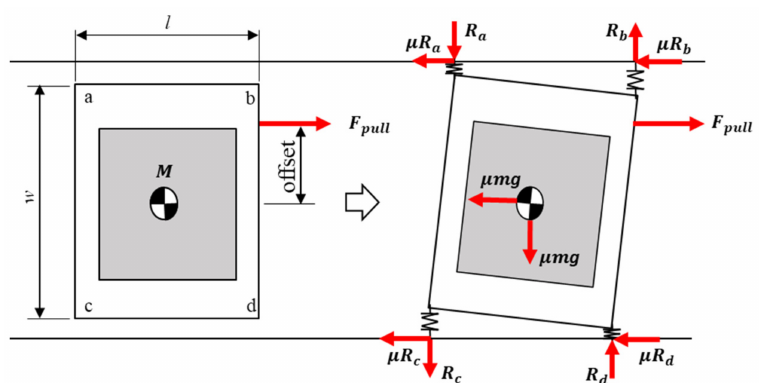
Figure 2. Scheme of an offset-driven platform mounted on two linear motion